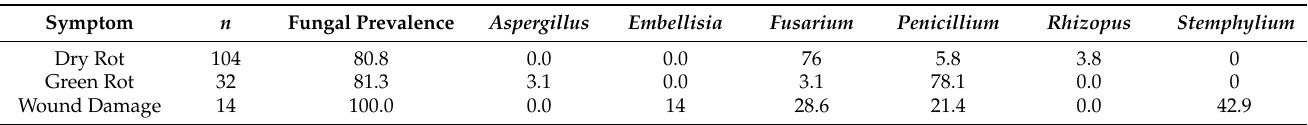
Table 1. Percentages of fungal genera isolated from symptomatic garlic cloves on the samples collected in two consecutive harvest seasons.